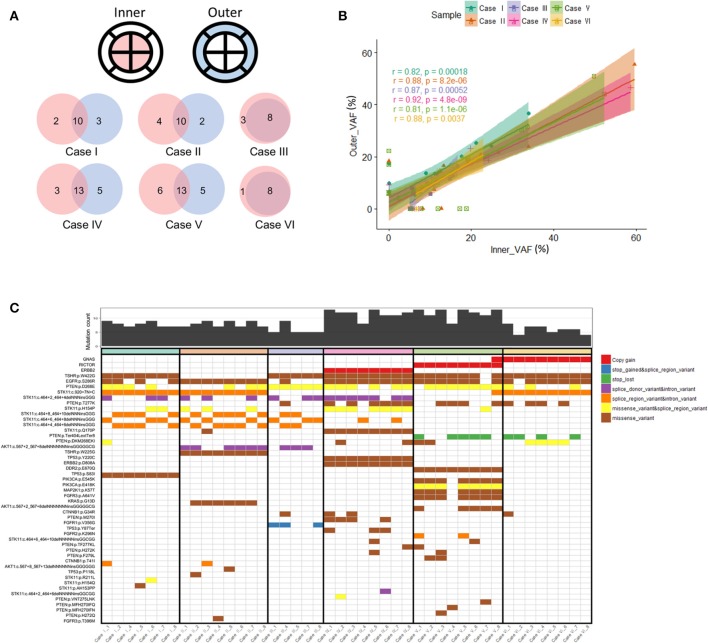
(A) Venn diagram illustrating overlapping somatic mutations detected in inner vs. outer biopsies. In all six cases more than half of mutations were shared between inner and outer biopsies. (B) Correlation coefficients of variant allele frequencies (VAFs) between inner and outer biopsies. The plot is representative of VAFs of identified SNVs and INDELs among the six cases. Mutations falling within amplified genes were not considered in the correlation analysis. The Pearson correlation coefficient between the variants from inner and outer biopsies on average was 0.81 or more. (C) Genomic landscape of mutations detected among all analyzable biopsies. In total 48 unique alterations were identified amongst 17 genes with evidence of both shared and non-shared mutations in the differing biopsies of the same primary tumor.